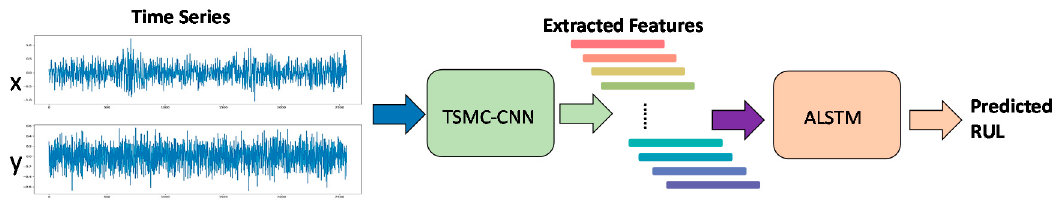
Figure 10. The network architecture of the TSMC-CNN-ALSTM method.